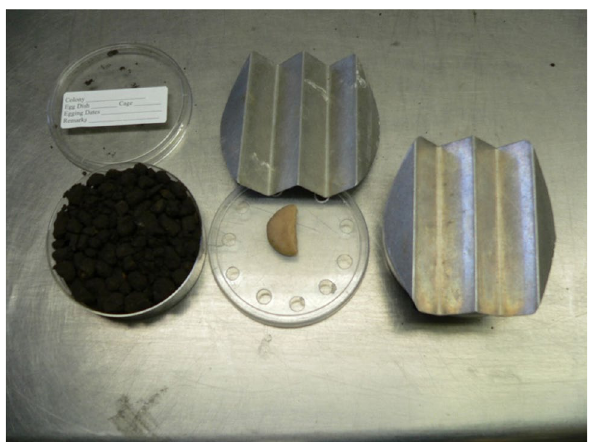
Figure 7. Optimized soil surface for oviposition